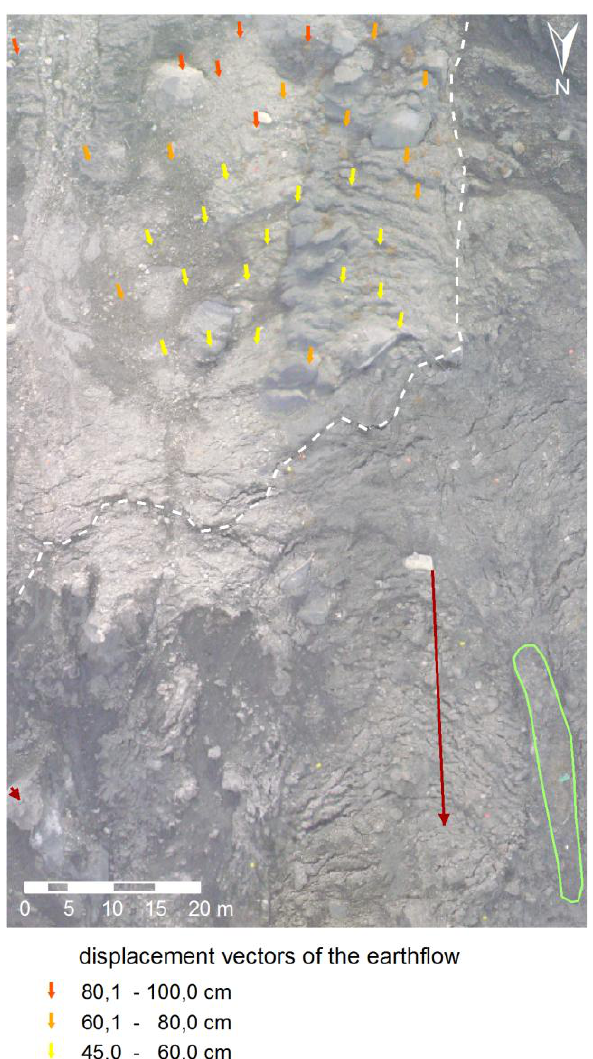
Figure 7. Horizontal displacements and scarp within the Super- Sauze landslide in October 2008